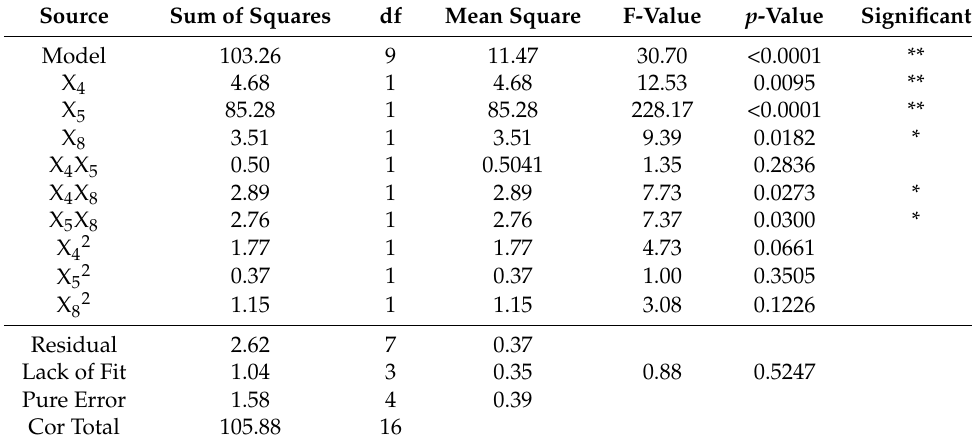
Table 8. Variance analysis of the stacking angle test regression